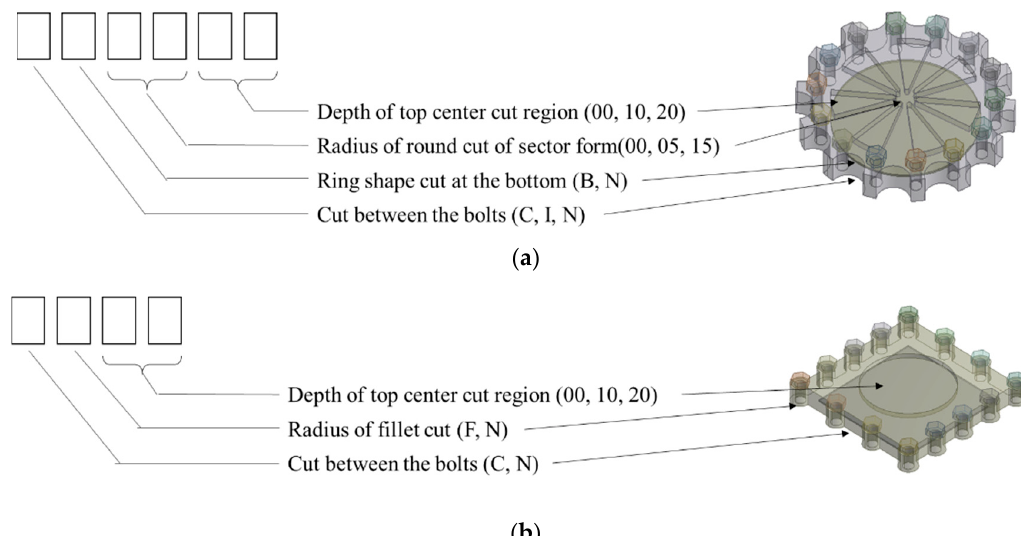
Figure 5. Code names of the parametric designs for the ( a ) circular and ( b ) square end plates.